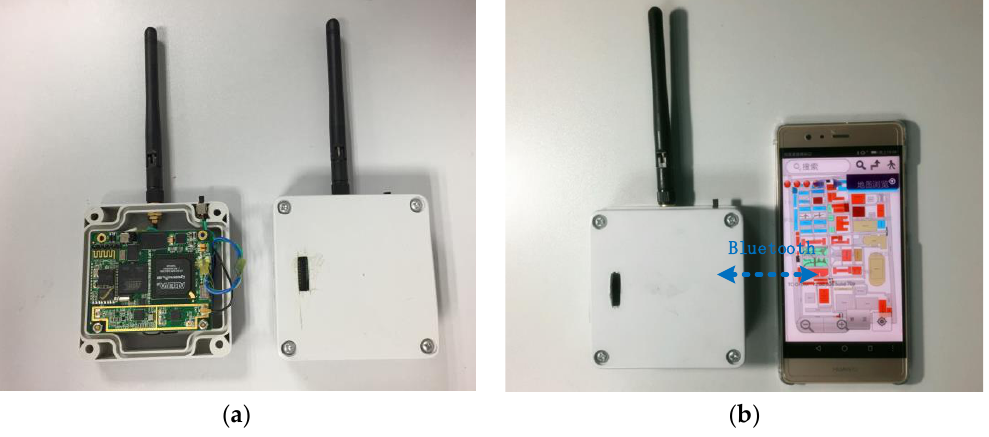
Figure 16. The positioning receiver: ( a ) is the internal and external structure of the receiver, and ( b ) shows that the receiver uploads the related data to the mobile phone through Bluetooth to display.